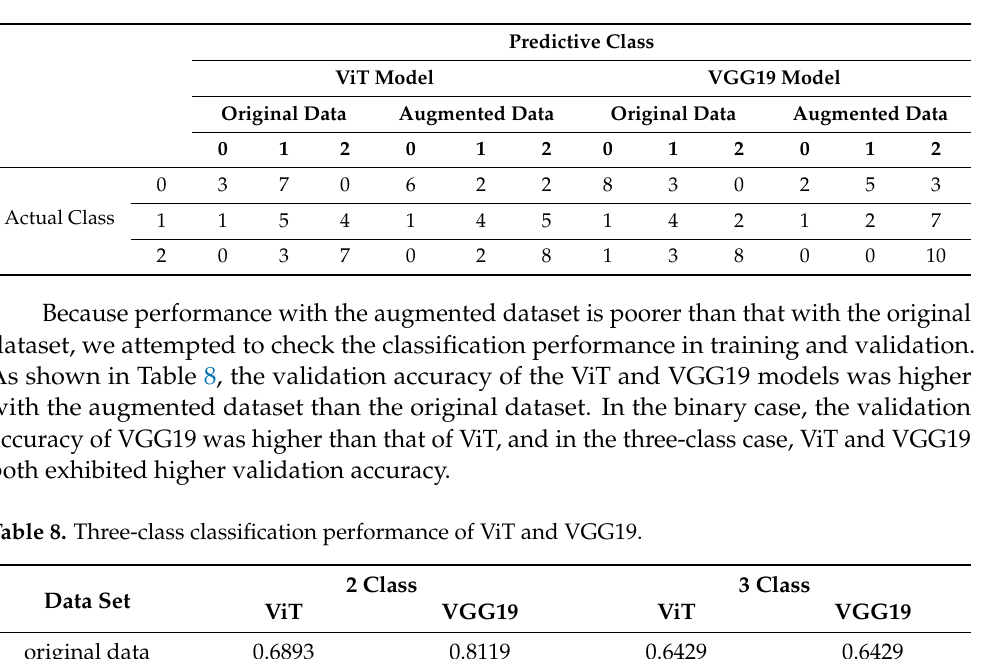
Table 7. Three-class classification confusion matrix of ViT and VGG19.